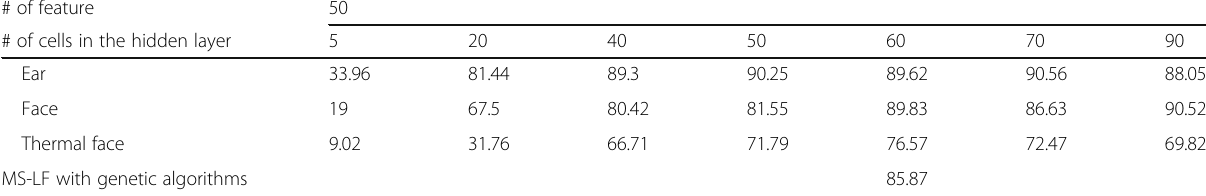
Table 4 Matching score-level fusion with eigenfeatures (#feature 50)